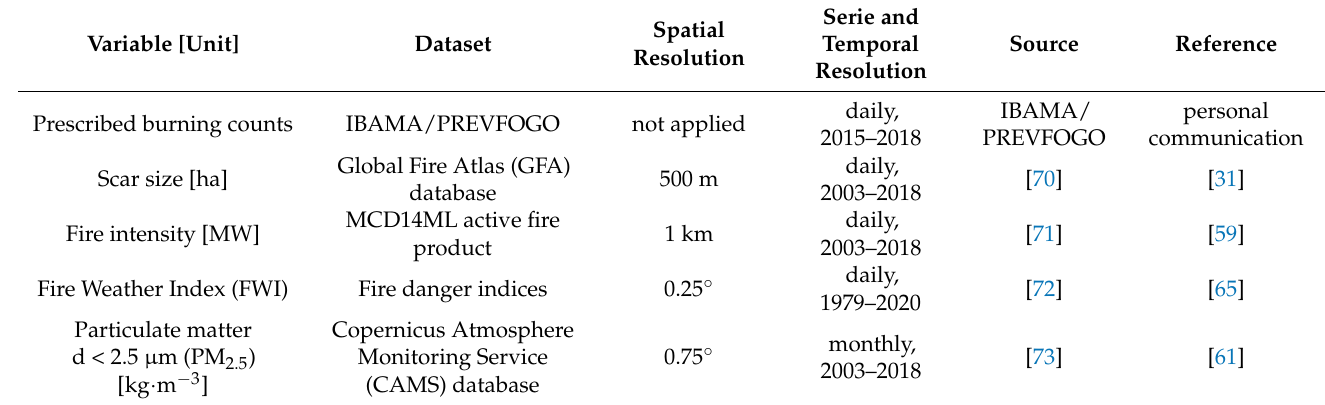
Table 1. Description of the variables and datasets used in this